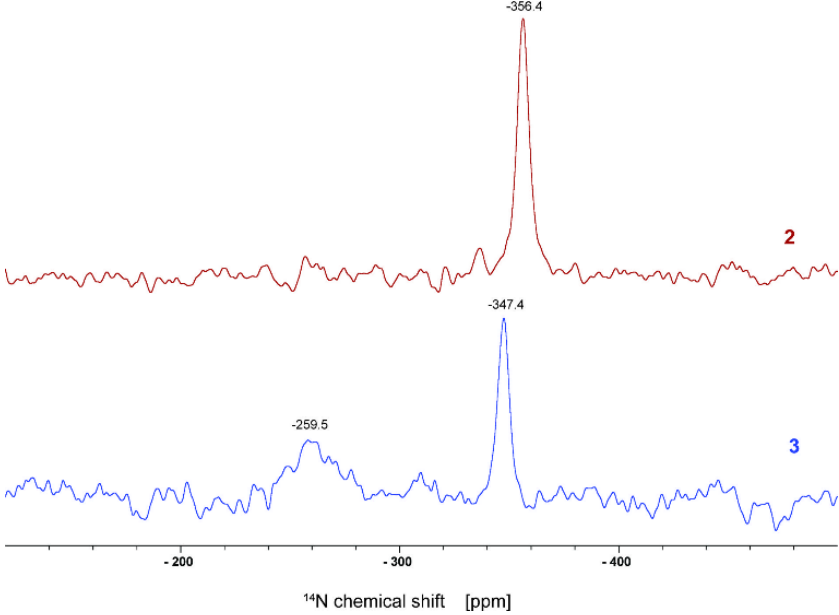
Figure 2. 15 N ss -NMR spectra of the: CHIT (red line) and CHIT-PAAA (blue line).